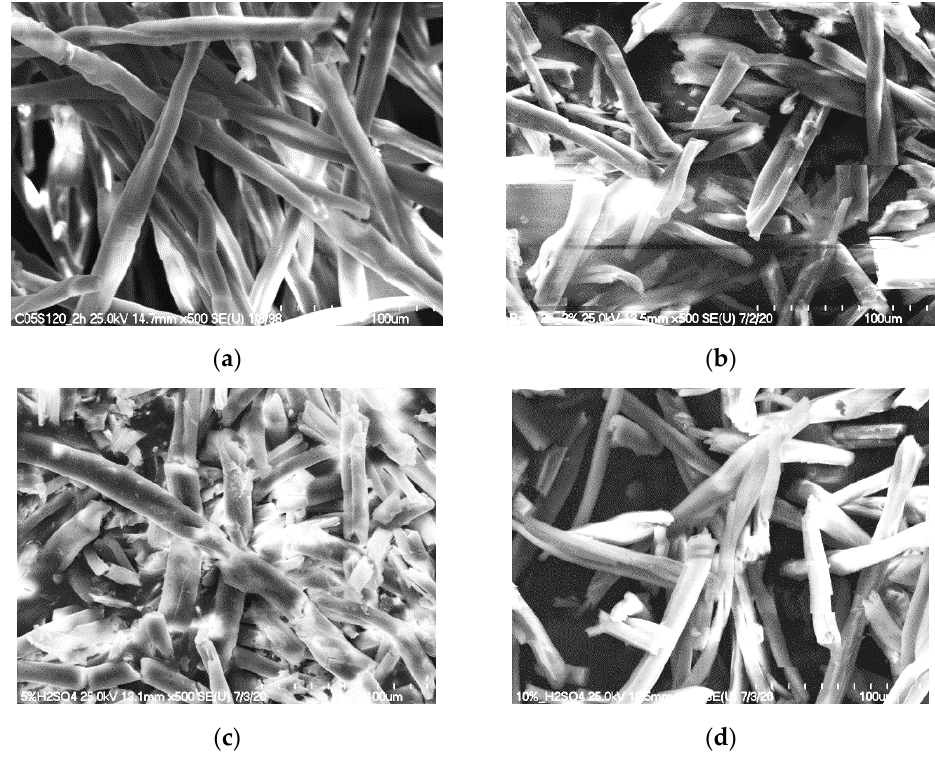
Figure 7. SEM photos of the solid residue after hydrolysis (120 °C, 2 h) of cotton with various concentrations of H 2 SO 4 : ( a ) 0.5%; ( b ) 2%; ( c ) 5%; ( d ) 10%.